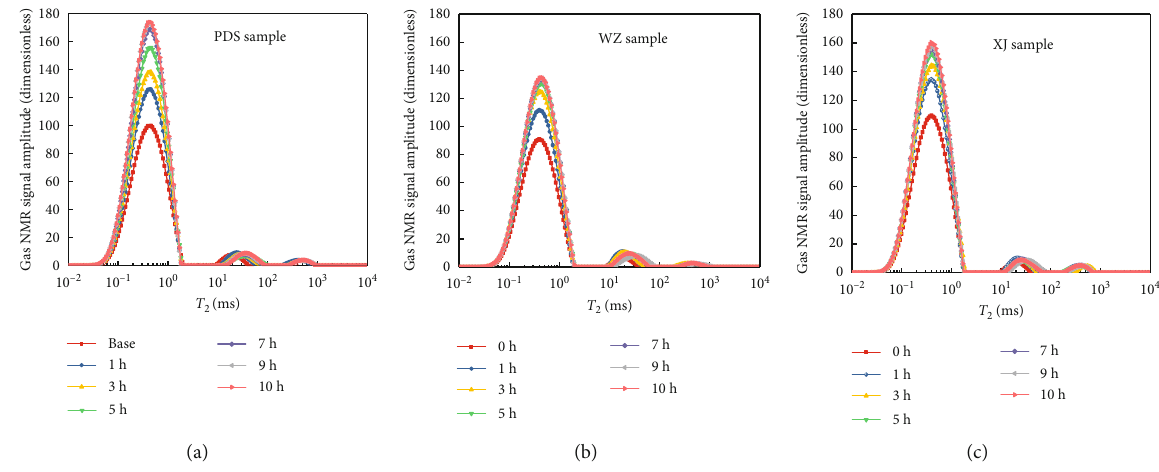
Figure 4: T 2 spectrum curves of experimental coal sample gas in the adsorption process.